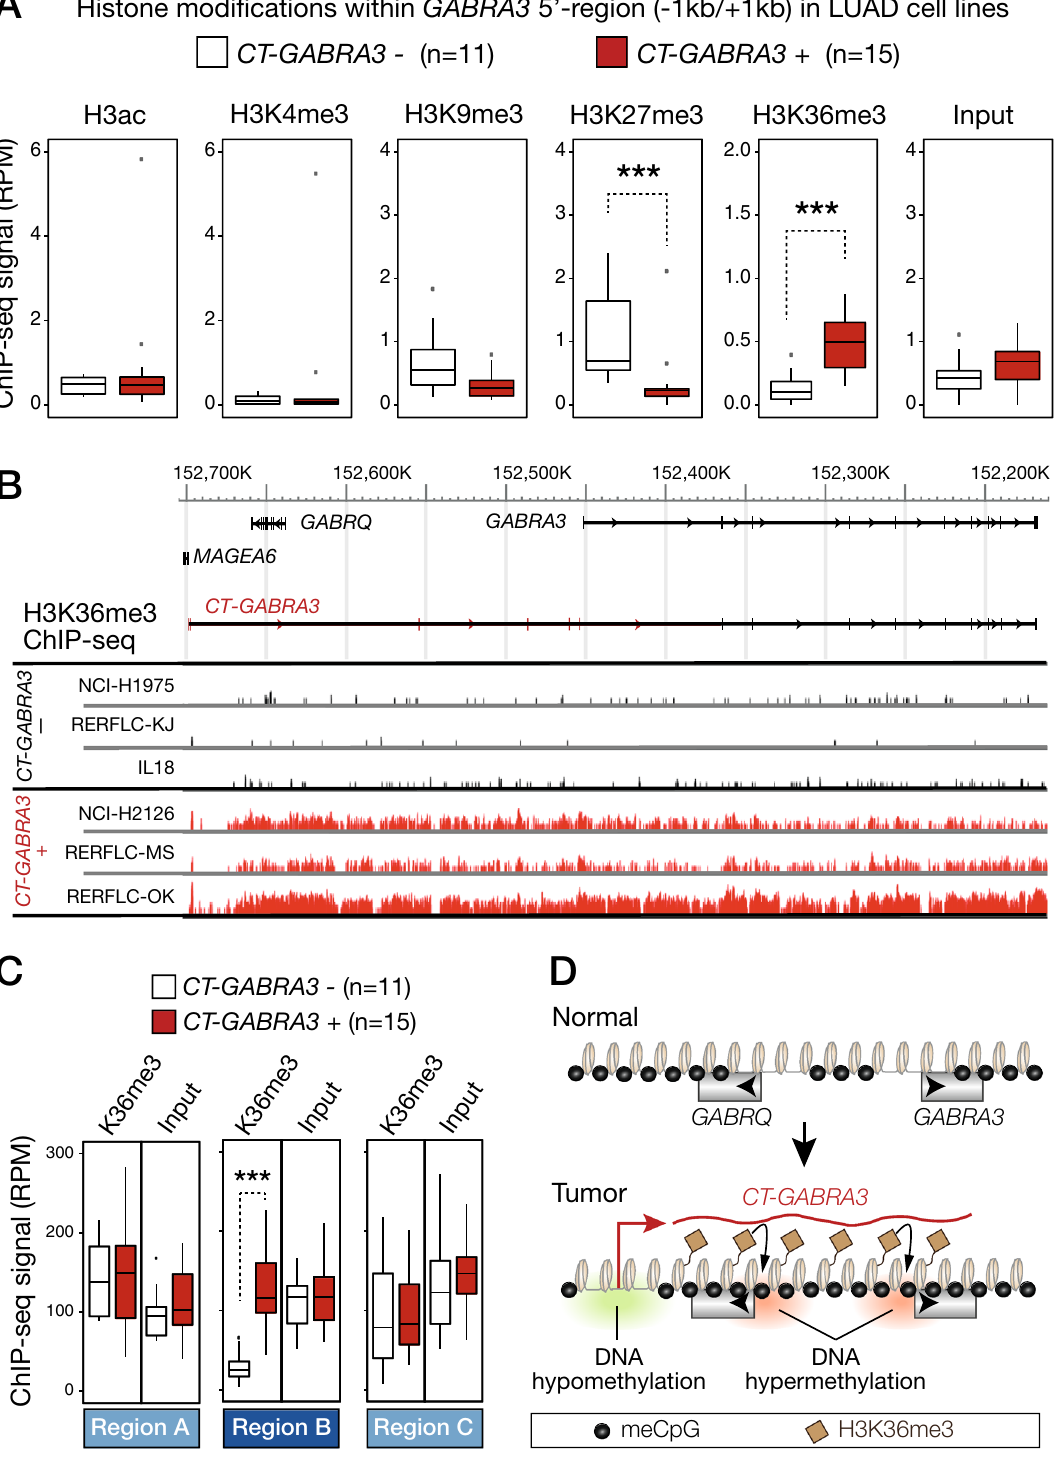
Figure 4. CT-GABRA3 transcription correlates with regional increases in H3K36 trimethylation. ( A ) ChIP-seq results for the indicated histone modifications were extracted from the DBTSS platform, and mean amounts of reads corresponding to the GABRA3 5 ′ region (− 1b/+ 1 kb) were compared in LUAD cell lines that do or do not express CT-GABRA3 . ***Mann–Whitney test, adjusted p -value < 0.001. ( B ) ChIP-seq profile for H3K36me3 (DBTSS browser) within the entire CT-GABRA3 transcription unit, in 3 LUAD cell lines that do not express CT-GABRA3 (-) and 3 that do express it (+). ( C ) Mean amounts of ChIP-seq reads for H3K36me3 or control input in the three defined 530 kb genomic segments (Region B: CT-GABRA3 transcription unit; Regions A and C : neighboring segments), were compared in LUAD cell lines that do or do not express CT-GABRA3 . ***Mann–Whitney test, p -value < 0.001. ( D ) Model establishing the link between DNA hypomethylation/activation of CT-GABRA3 and DNA hypermethylation of GABRQ and GABRA3 promoters in tumor